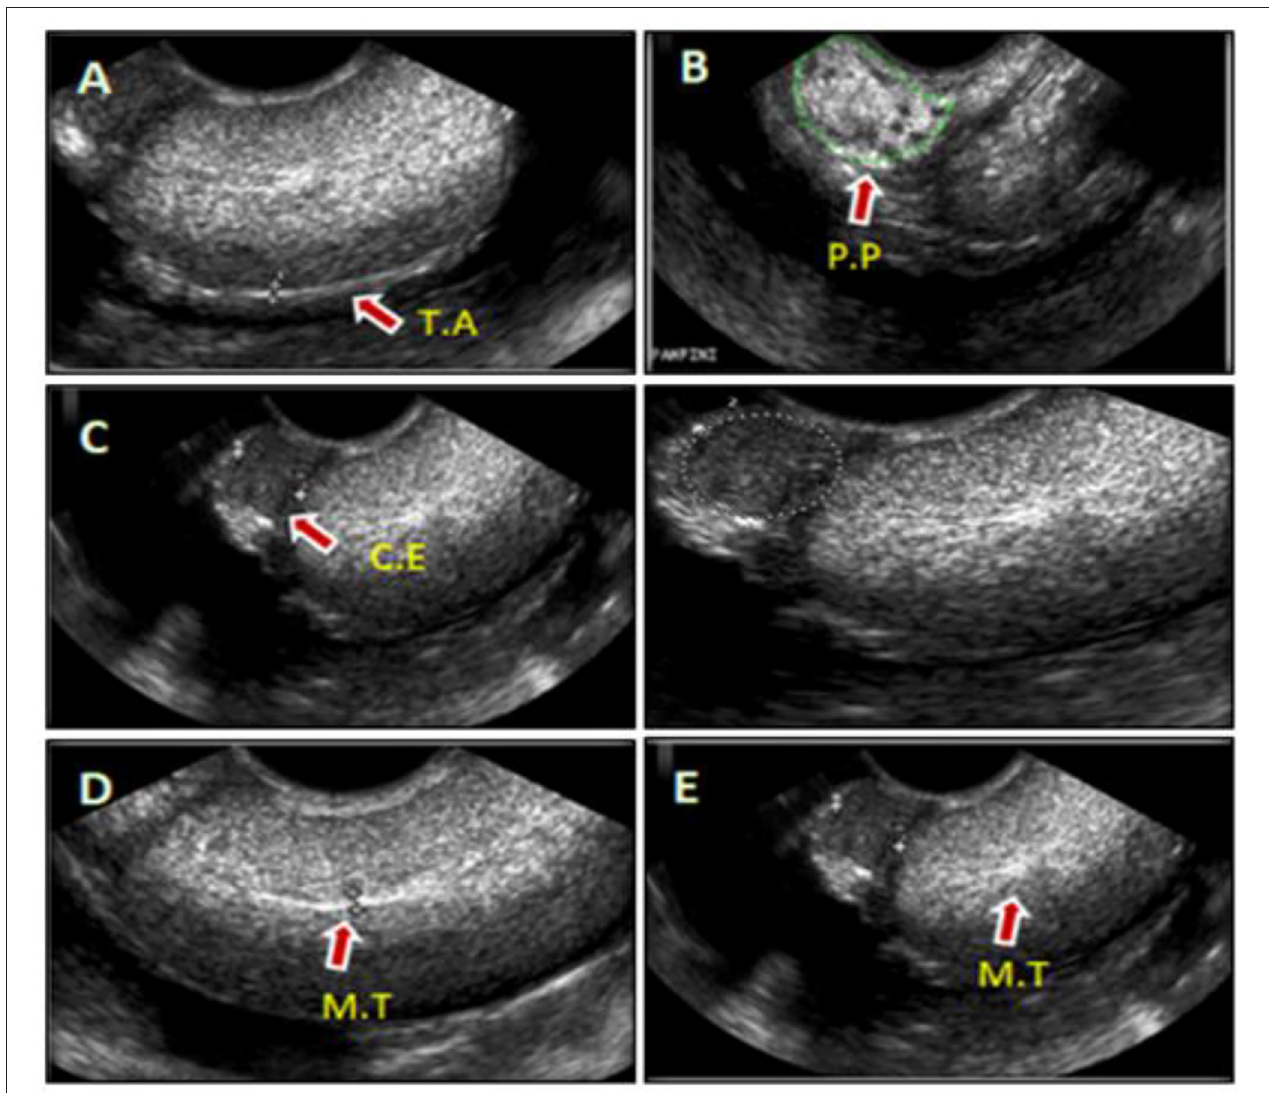
FIGURE 1 | Representative images of camel’s testis and cauda epididymal parenchyma scanned by the ultrasound (US) during rut season (A–E) . The sonograms were shown in the sagittal or cross-sections of testis and that associated epididymis, such as; tunica albuginea (T.A) (A) , pampiniform plexus (P.P) (B) , cauda epididymis (C.E) (C) , and mediastinum of the testis (M.T) (D,E) .